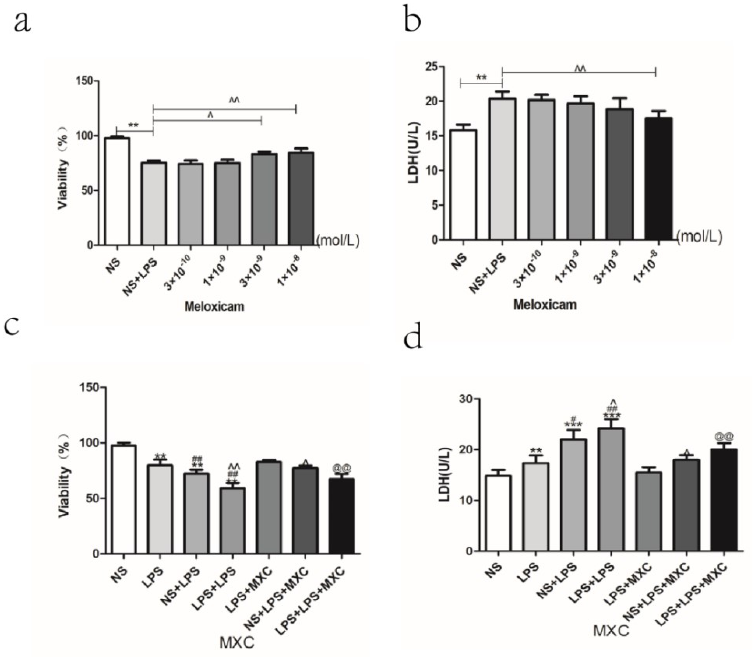
Figure 7. Effect of MXC on the neuron viability and the LDH leakage rate in LPS-treated primary cultured neurons of offspring from prenatal inflammation exposure: ( a ) Effect of MXC on the survival rate in LPS-treated neurons. ( b ) Effect of MXC on the LDH leakage rate in LPS-treated neurons. ( c ) Effect of MXC on the survival rate of LPS-treated primary neurons of offspring from prenatal inflammation exposure. ( d ) Effect of MXC on the LDH leakage rate in LPS-treated primary neurons of offspring from prenatal inflammation exposure. Data are mean ± SEM, n = 6. (** p < 0.01, *** p < 0.001 vs. NS group; # p < 0.05, ## p < 0.01 vs. LPS group; ˆ p < 0.05, ˆˆ p < 0.01 vs. NS + LPS group; @@ p < 0.01 vs. LPS + LPS